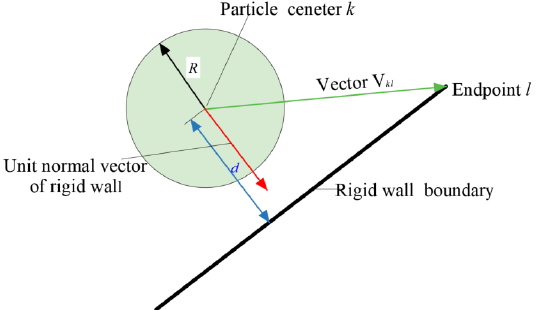
Figure 2. Schematic diagram of boundary contact between particles and rigid